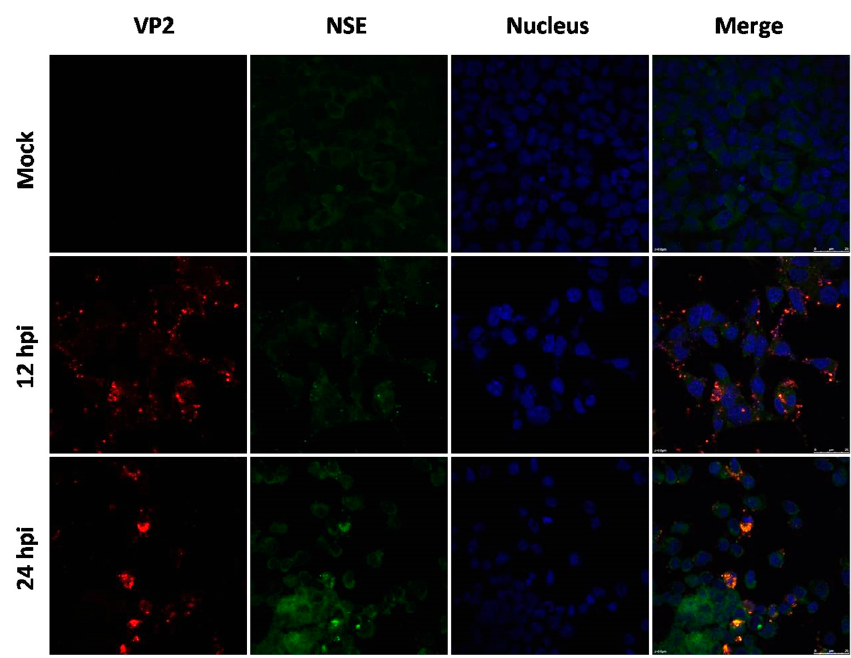
Figure 4. Immunofluorescence assay in mouse neuroblastoma Neuro-2a cells (magnification 630 ×). Cells were infected with EV71 Hun11-4, and mock-infected or infected cells were fixed at 12 and 24 hpi and incubated with mouse anti-EV71 VP2 antibody and rabbit anti-NSE antibody, followed by incubation with FITC-(green) and TRITC-(red) conjugated secondary antibodies. The cells were also stained with DAPI (blue) to visualize the nuclei.